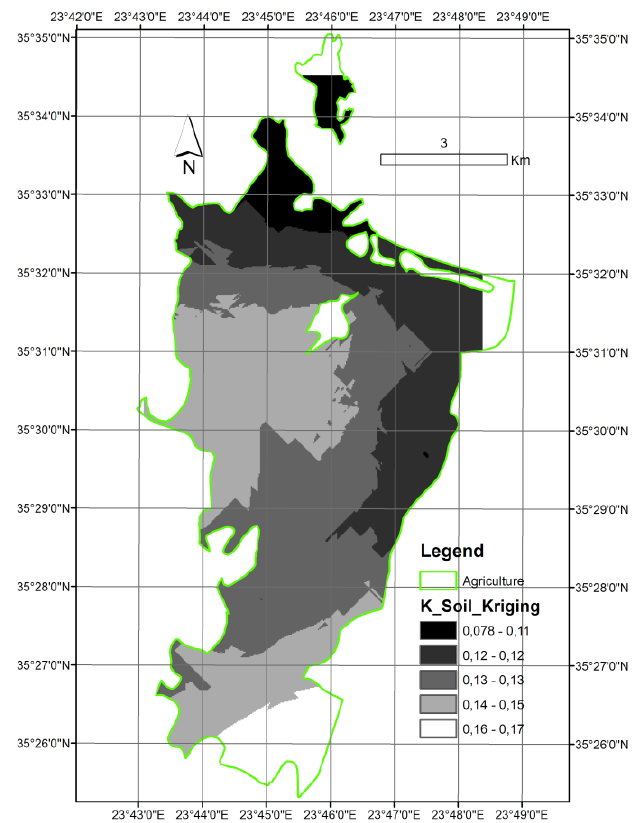
Figure 6. K-layer derived with Ordinary Kriging of K-values calculated at the soil-sampled locations with USDA